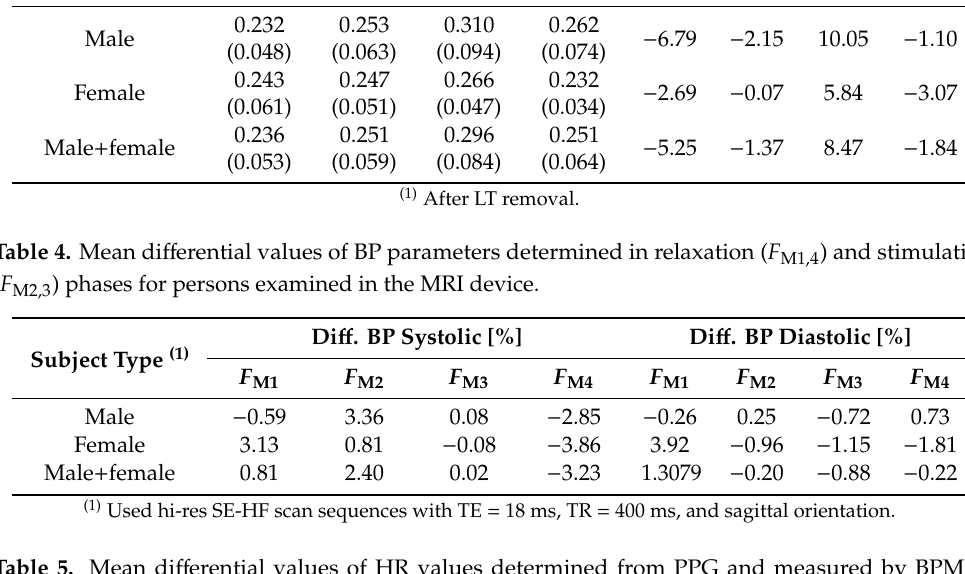
Table 5. Mean differential values of HR values determined from PPG and measured by BPM in relaxation ( F M1,4 ) and stimulation ( F M2,3 ) phases for persons examined in the MRI device.